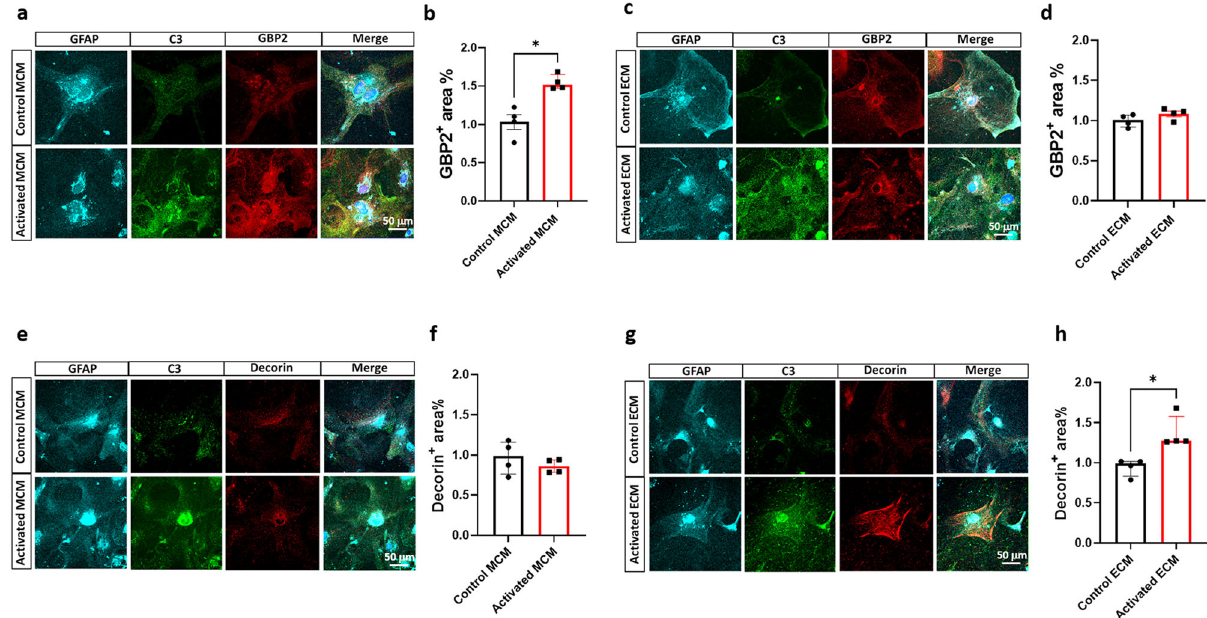
Fig. 5 Reactive endothelial cells induce C3 + astrocytes distinct from reactive microglia. a , c Triple immuno fl uorescence of astrocytes (GFAP, cyan), complement component 3 (C3, green) and GBP2 (red) in primary astrocyte cultures. b , d Quanti fi cation of GBP2 + area (%) of control or activated MCM/ ECM-treated astrocytes, an increased presence of GBP2 immunoreactivity is observed only in astrocytes stimulated with activated MCM. e , g Triple immuno fl uorescence of astrocytes (GFAP, cyan), complement component 3 (C3, green) and Decorin (red) in primary astrocyte cultures. f , h Quanti fi cation of Decorin + area (%) of control or activated MCM/ECM-treated astrocytes, an increased presence of Decorin immunoreactivity is observed exclusively in astrocytes stimulated with activated ECM. The number of cells analyzed was 20 per image from 10 different images per culture from 4 independent cultures. Results are shown as the median ± IQR of n = 4. Asterisks indicate signi fi cant differences were, * P < 0.05 by Mann-Whitney test. Scale bar 50 μ